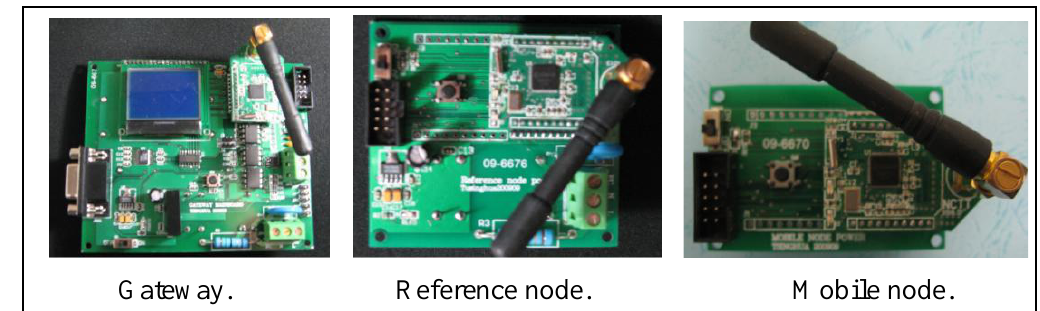
Figure 10. The devices in the positioning